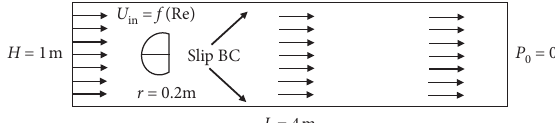
Figure 1: Geometrical description of the channel.